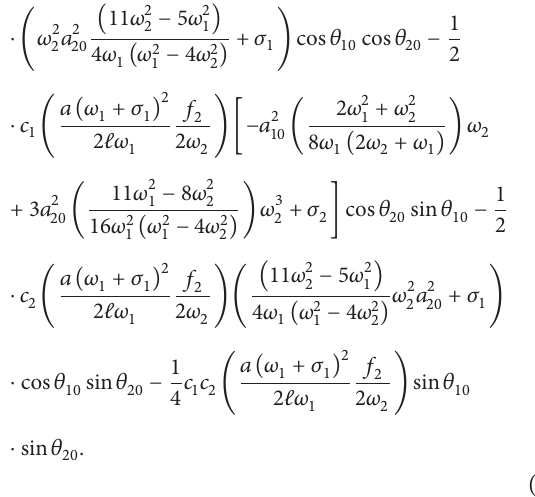
Figure 7: Projection on the phase plane when 𝜔 2 = 0.1 [rad ⋅ s −1 ], 𝜎